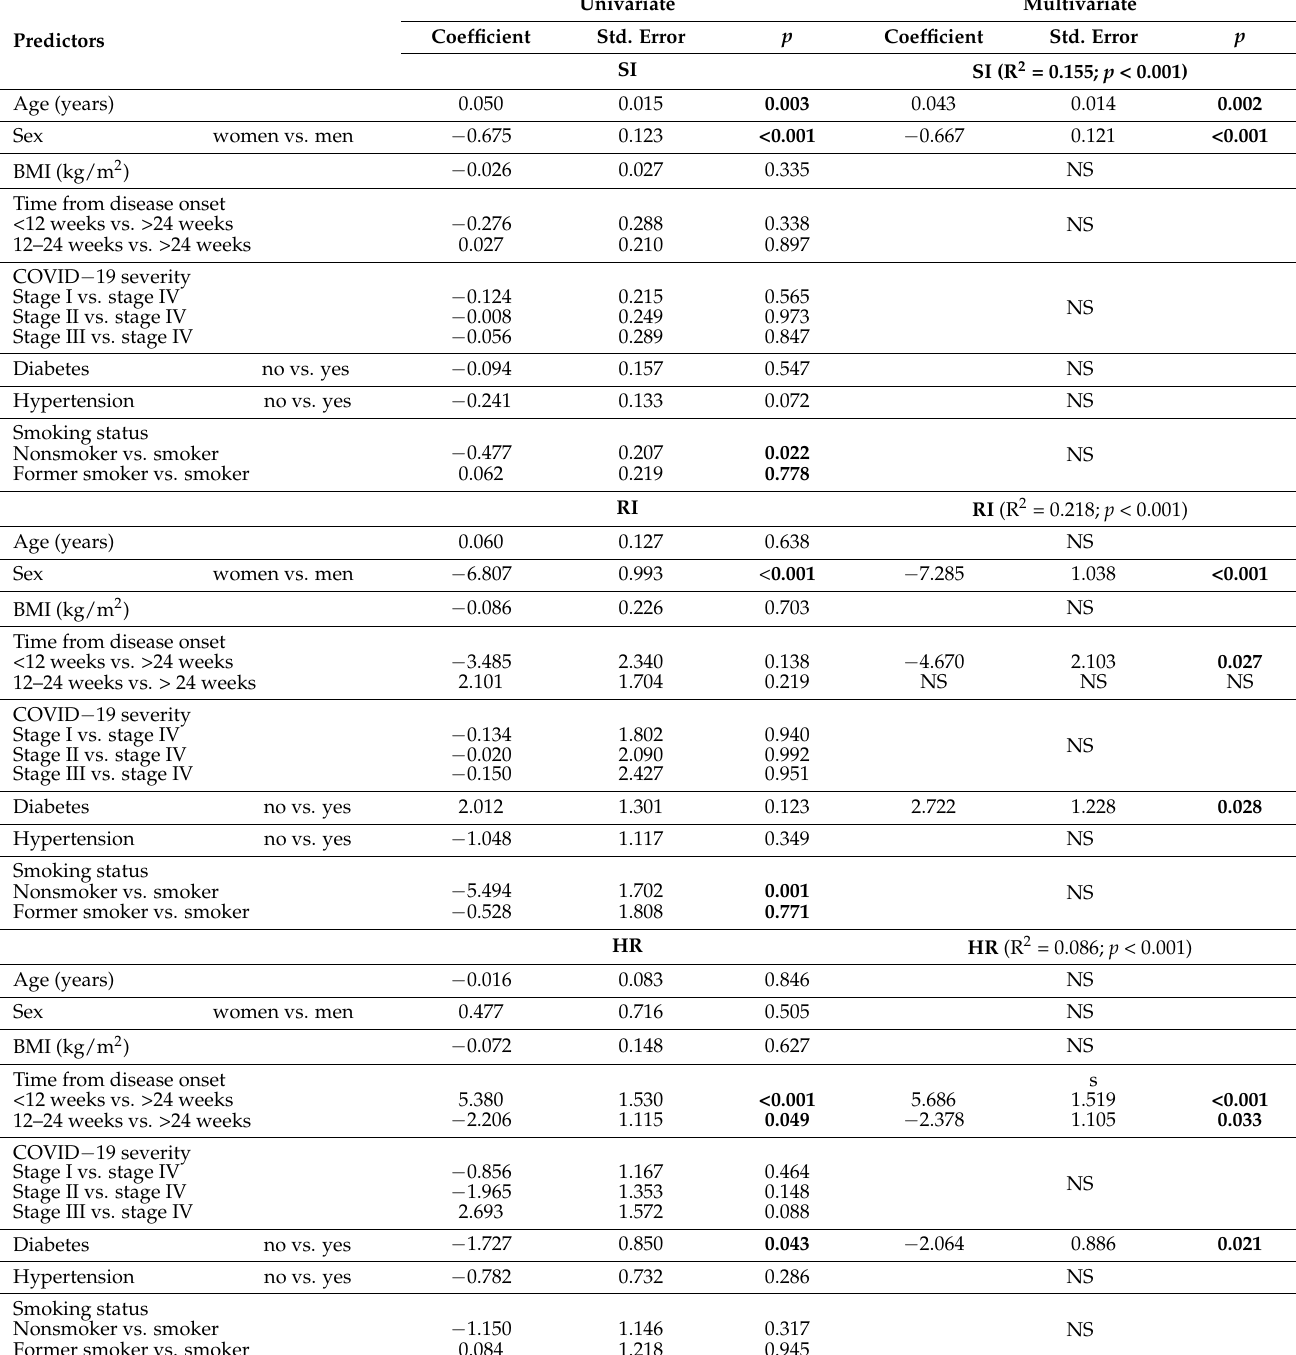
Table 4. The results of linear regression analysis (uni- and multivariate) of the influence of selected risk factors for arterial stiffness after adjusting age, sex, BMI, stage of the severity of the acute COVID-19, the time from the disease onset, smoking status, hypertension, and